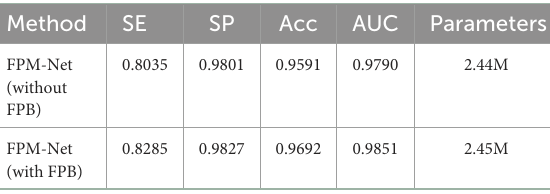
TABLE 2 Performance measures with ablation